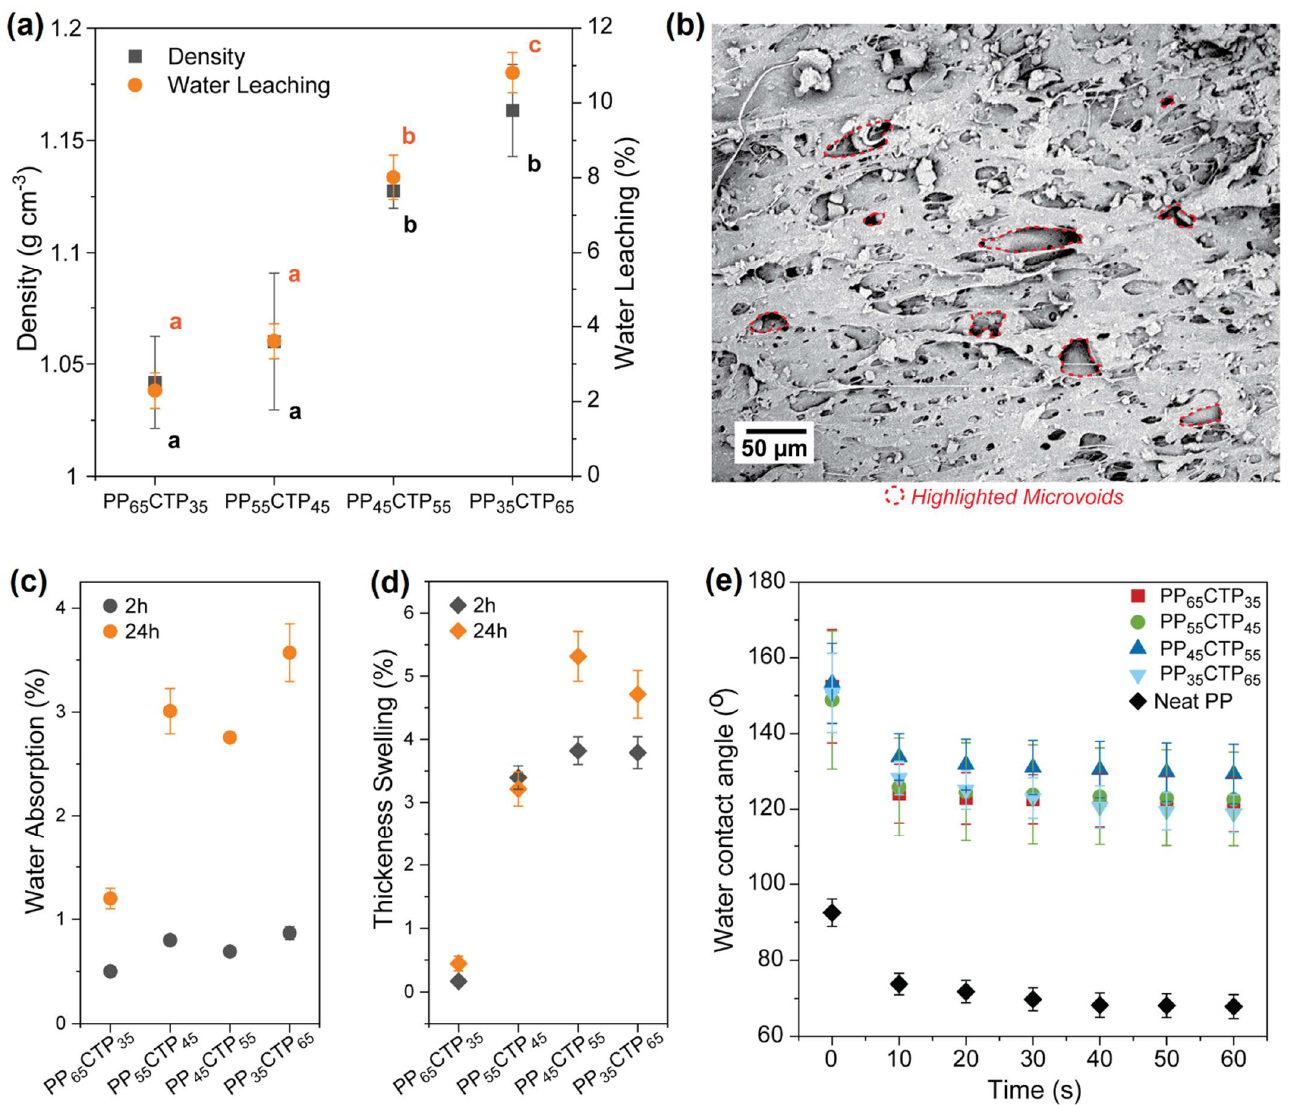
Figure 2. Water-composite relationships. ( a ) Density and water leaching of the PP-CTP composites comprising CTP at 35 (PP 65 CTP 35 ) to 65 wt% (PP 35 CTP 65 ). ( b ) Scanning electron microscopy of the PP 55 CTP 45 composite, displaying the presence of microvoids across its structure. ( c ) Water absorption and ( d ) thickness swelling (TS) after 2 and 24 h. ( e ) Water contact angle kinetics for the PP-CTP composites. Values having the same letter ( a ) are not significantly different (Fisher LSD test).